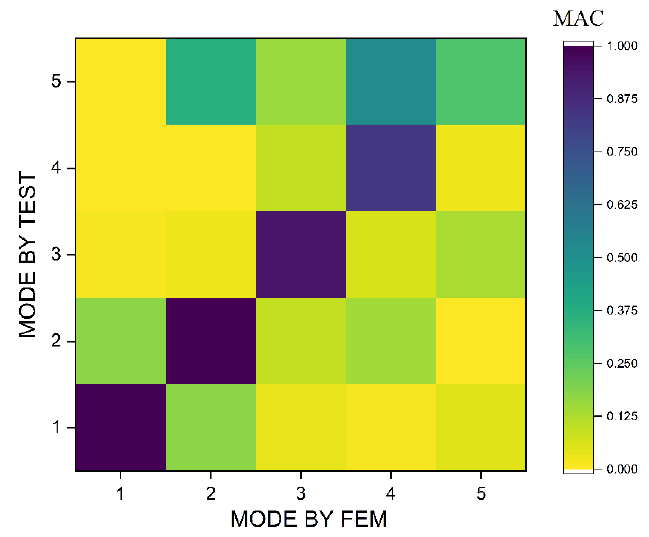
Figure 5. Modal Assurance Criteria (MAC) for the first five modes.